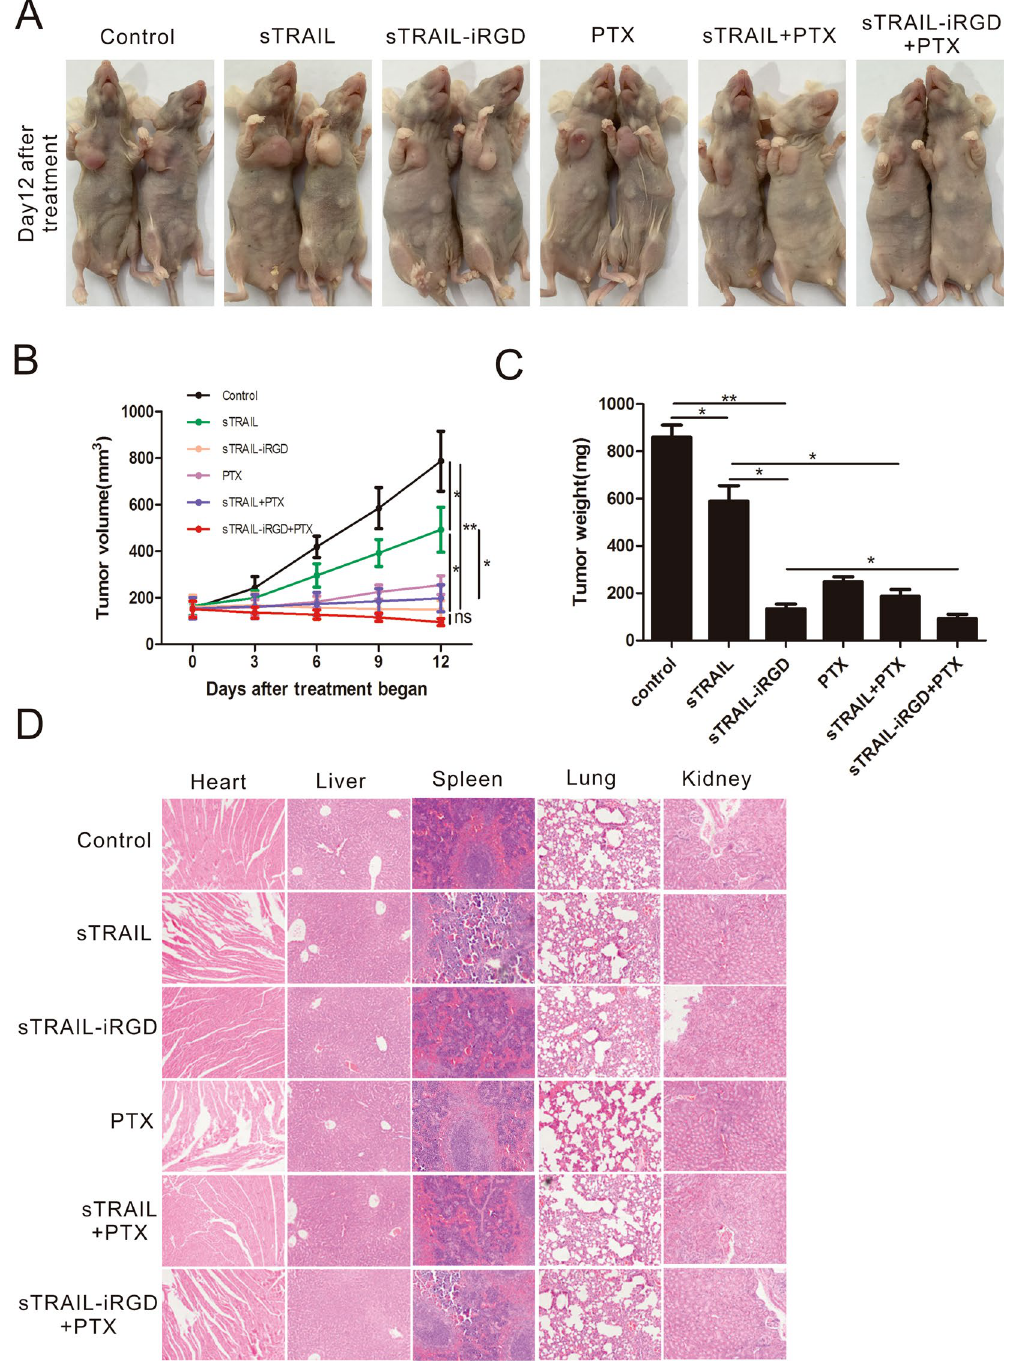
Figure 7. sTRAIL-iRGD suppresses tumor growth with no toxic effects in a xenograft model. MKN45 cells were subcutaneously injected into the right armpits of nude mice and allowed to establish xenografts for two weeks. ( A ) PBS, sTRAIL, sTRAIL-iRGD, PTX, sTRAIL + PTX or sTRAIL-iRGD + PTX were intraperitoneally injected into mice. Photo taken at 12 days post treatment. MKN45 xenograft volumes from treated animals (n = 6). ( B ) Mean tumor weights after treatment. ( C ) Morphological details were investigated using H&E staining. ( D ) Scale bar represents 50 μ m. * p ≤ 0.05; ** p ≤ 0.01; ns, not